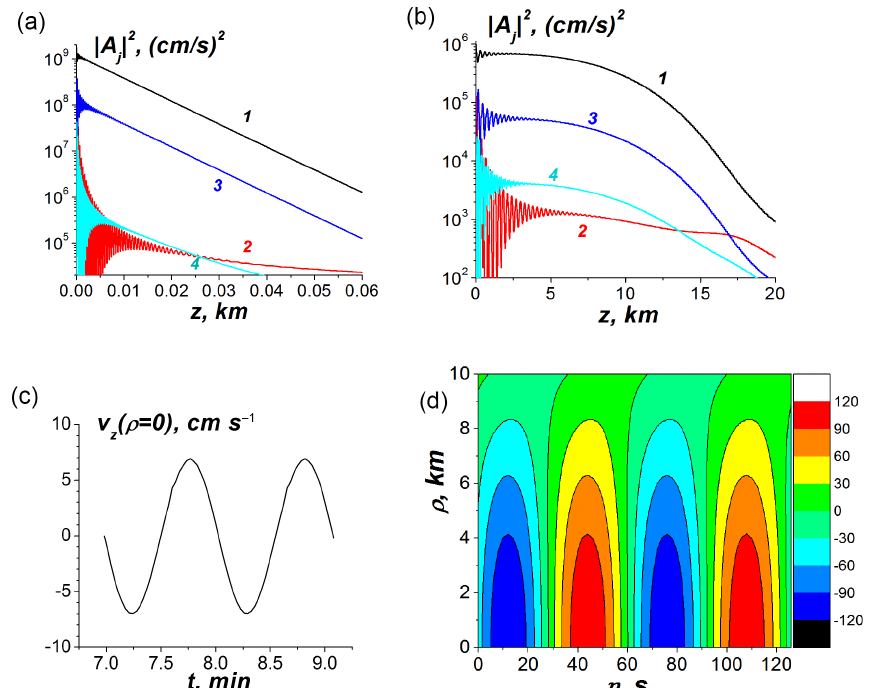
Figure 2. The double frequency transform 600Hz → 25Hz → 0.016Hz from an initial transverse SW width of 1m at a frequency of 600Hz (cid:12) (cid:12) 2 ( A and an amplitude of 420ms − 1 : (a) the dependence of (cid:12) A j (cid:12) 1 , A 2 , etc. are maximum amplitudes of harmonics at the frequency 600Hz), (cid:12) (cid:12) 2 (squares of the maximum amplitudes of harmonics of the intermediate frequency f = 25Hz) for the second (b) the dependence of (cid:12) A j (cid:12) transform, and (c, d) distributions of the air velocity v z in ULF AGWs (cms − 1 units) at the heights z = 130km and z = 300km, respectively. The dependence v z ( t ) in the centre of the beam in panel (c) is given with an account of the time